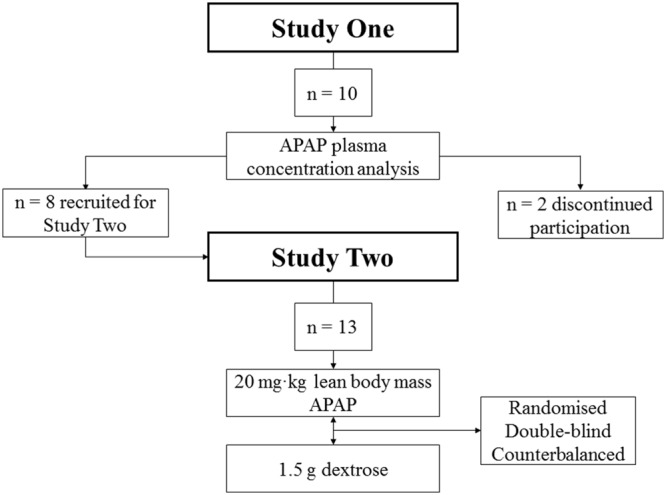
Trial profile. APAP, acetaminophen.